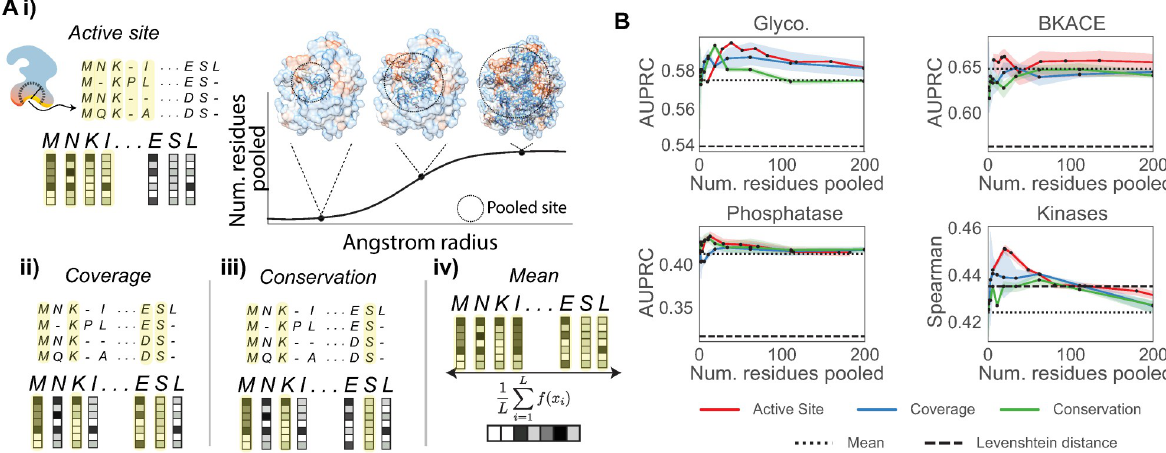
Fig 5. Structure-based pooling improves enzyme activity predictions. (A) Different pooling strategies can be used to combine amino acid representations from a pretrained protein language model. Yellow coloring in the schematic indicates residues that will be averaged to derive a representation of the protein of interest. (i) We introduce active site pooling, where only embeddings corresponding to residues within a set radius of the protein active site are averaged. By increasing the angstrom radius from the active site, we increase the number of residues pooled. Crystal structures shown are taken from the BKACE reference structure, PDB: 2Y7F rendered with Chimera [60]. (ii, iii) We also introduce two other alignment based pooling strategies: coverage and conservation pooling average only the top- k alignment columns with the fewest gaps and highest number of conserved residues respectively. (iv) Current protein embeddings often take a mean pooling strategy to indiscriminately average over all sequence positions. (B) Enzyme discovery AUPRC values are computed for various different pooling strategies. Each strategy is tested for different thresholds of residues to pool, comparing against both KNN Levenshtein distance baselines and a mean pooling baseline. The same hyperparameters are used as set in Fig 2 for ridge regression models. The kinase repurposing regression task from Hie et al. is shown with Spearman’s ρ instead of AUPRC as interactions are continuous, not binarized. All experiments and are repeated for 3 random